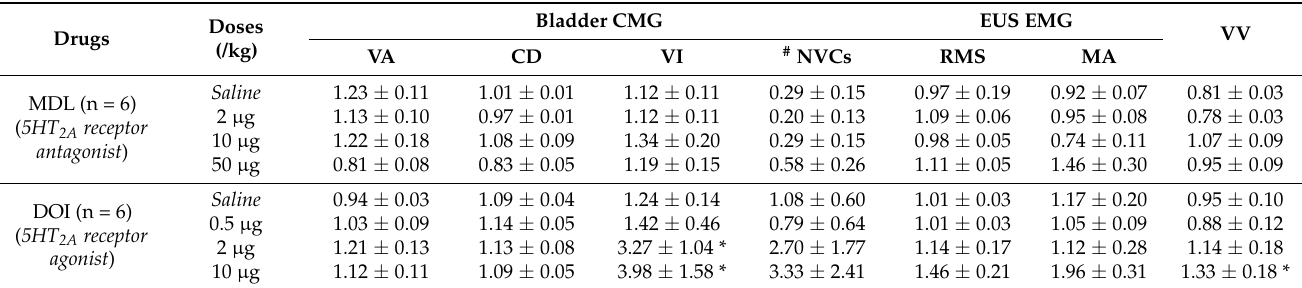
Table 2. Normalized parameters of bladder cystometry and EUS EMG activity in SCI rats ( i.t. administration). Doses Drugs